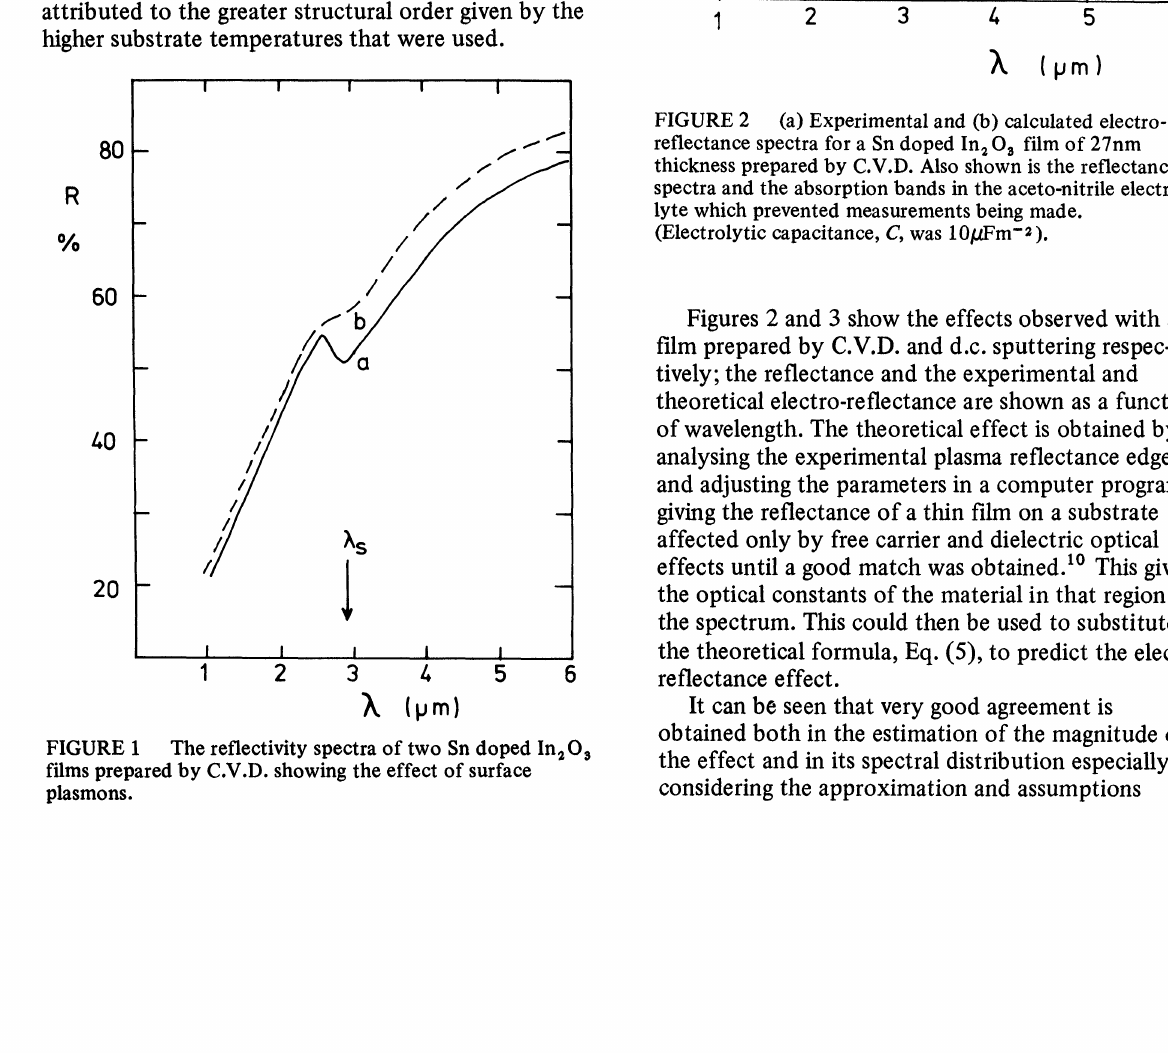
The reflectivity spectra of two Sn doped In Oa films prepared by C.V.D. showing the effect of surface plasmons.